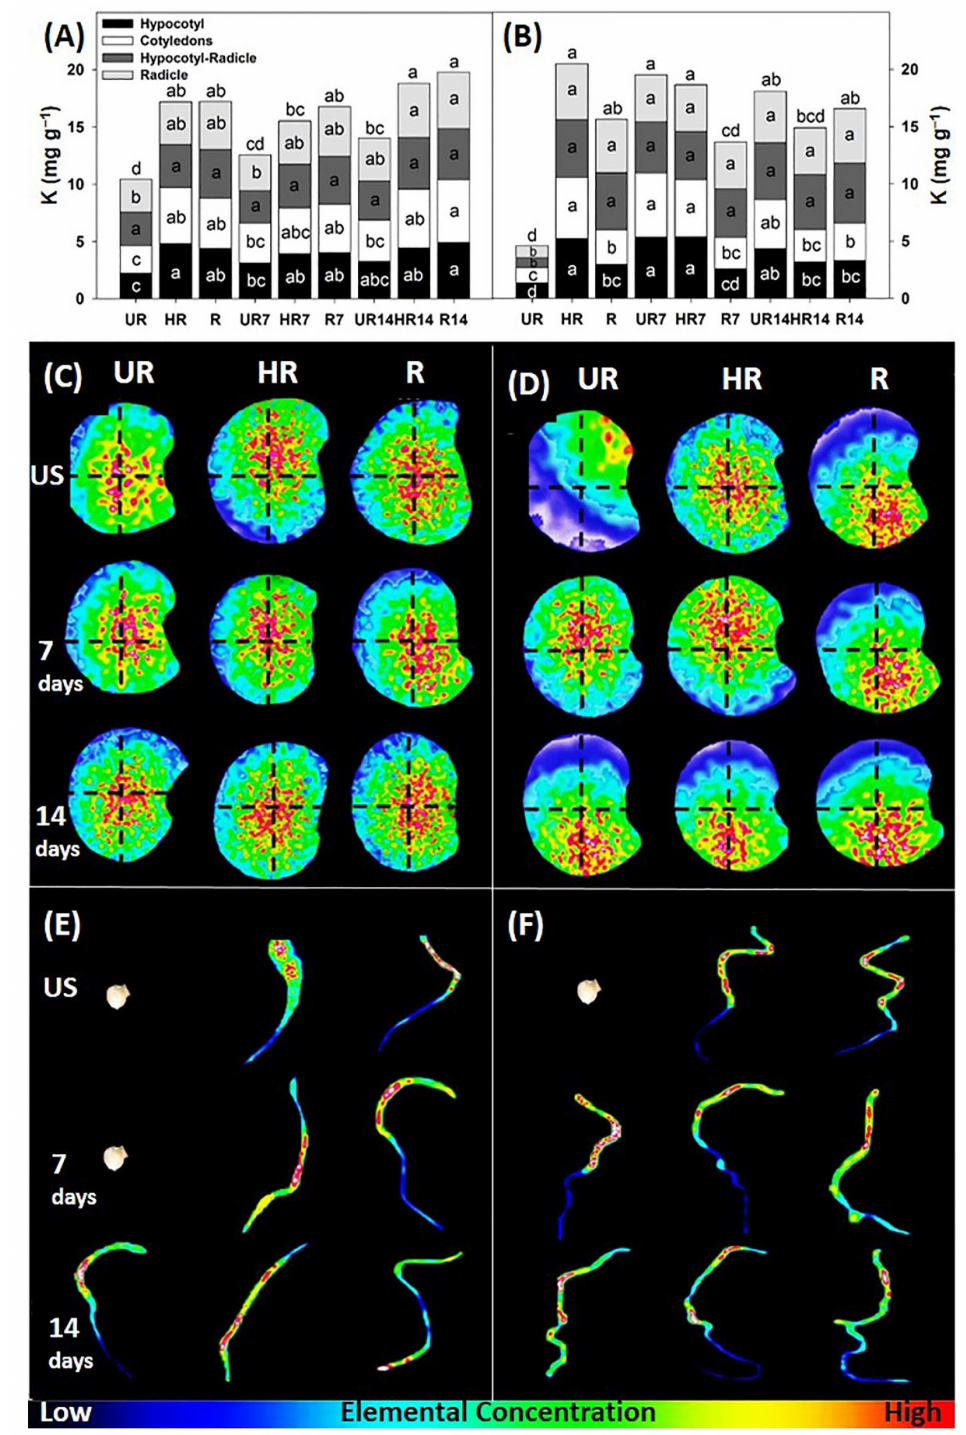
Figure 2. K concentration in seeds pre-imbibition ( A ) and post-imbibition ( B ), K distribution in habanero pepper seeds pre-imbibition ( C ) and post-imbibition ( D ), habanero seedlings at 10 ( E ) and 14 days ( F ) after sowing, of seeds of unripe (UR), half-ripe (HR), and ripe (R) fruits; unstored (US) and stored for 7 and 14 days postharvest. Colors in panels ( C – F ) are based on a relative intensity scale (reported at the bottom of the figure) generated on the intensity of the X-ray fluorescence K α peak of K in the samples. Data are means. Different letters indicate statistically significant differences among treatments (Duncan, p ≤ 0.05, n =